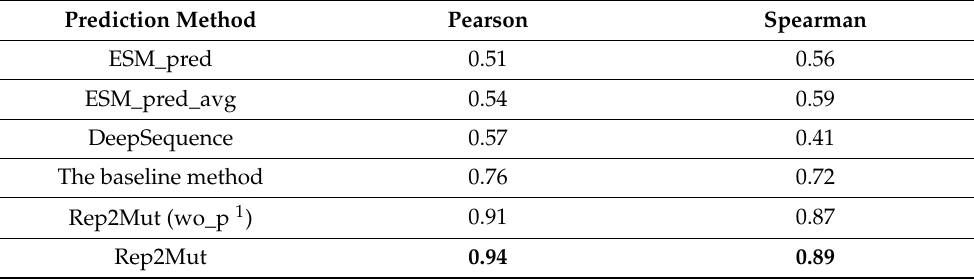
Table 1. Pearson and Spearman correlation coefficients comparing the experimental activities to predictions from Rep2Mut and the state-of-the-art methods.